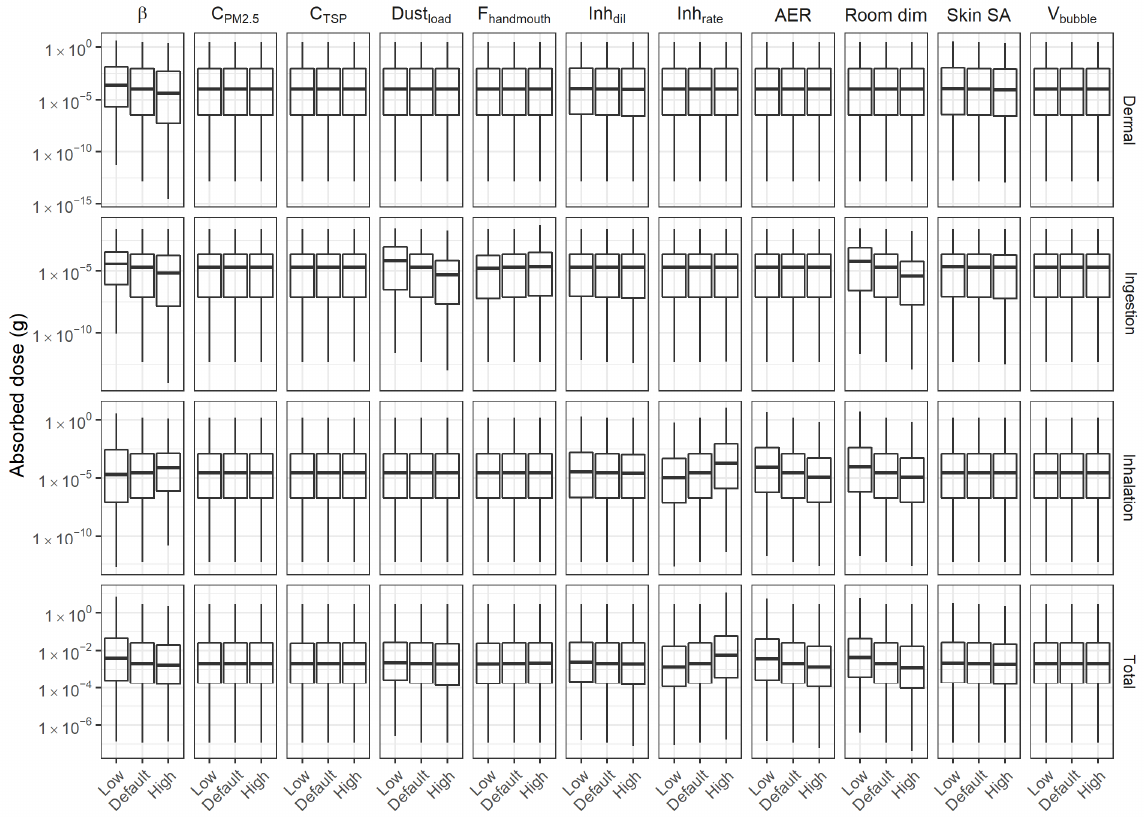
Figure 3. Outputs of one-way sensitivity analysis. Each row represents one exposure route (the bottom row represents total exposure). Each column represents one model parameter. β : Air flow rate between user bubble and larger room (m 3 /hour). C PM2 . 5 : Background indoor PM2.5 concentration (µg/m 3 ). C TSP : Background indoor total suspended particulate concentration (µg/m 3 ). Dust load = Mass of dust on the floor per unit area (g/m 2 ). F handmouth = Fraction of chemical transferred from hand to mouth (unitless). Inh dil = Dilution factor for products used outdoors (unitless). Inh rate = Inhalation rate (m 3 /day). AER = Building air exchange rate (residential) (# air changes/hour). Room dim = Dimension of one side of square room (m). Skin SA = Skin surface area (m 2 ). V bubble = Air volume of near-field user bubble (m 3 ). Within each panel, three box-and-whisker plots represent the distribution of intakes (absorbed doses) via the specified route at the low, default, and high values of the specified parameter (as marked on the horizontal axis). Low, default, and high values for each parameter are defined in Table 1. Lower and upper hinges correspond to the first and third quartiles (the 25th and 75th percentiles). The upper whisker extends from the hinge to the largest value no further than 1.5 × IQR (distance between the first and third quartiles) from the hinge. The lower whisker extends from the hinge to the smallest value at most 1.5 × IQR of the